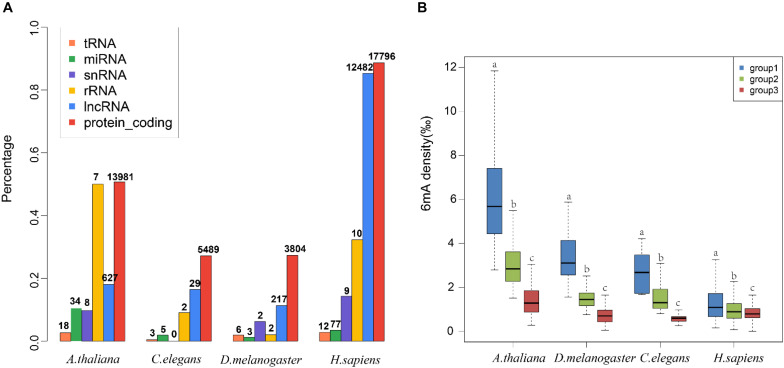
Distribution pattern of 6mA modification in non-coding genes in four species. (A) The percentages of genes containing 6mA modification in different gene categories were shown in histogram. The numbers of 6mA-methylated genes in different categories were shown above the histogram. (B) The 6mA density of different lncRNA gene length groups was shown in boxplot. The different letters shown above the box meant the significant difference in Duncan multiple-range test.